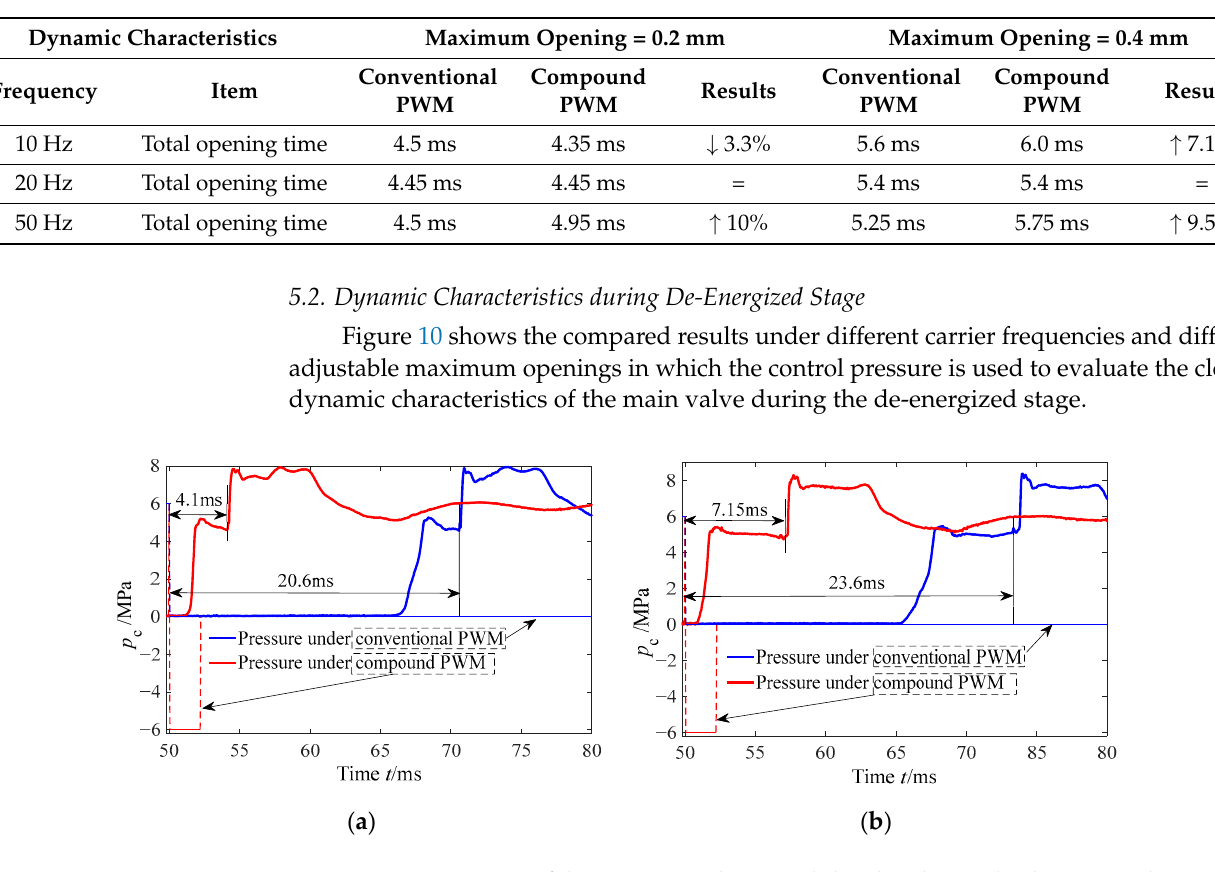
Table 2. Comparison of the total opening time during the energized stage.